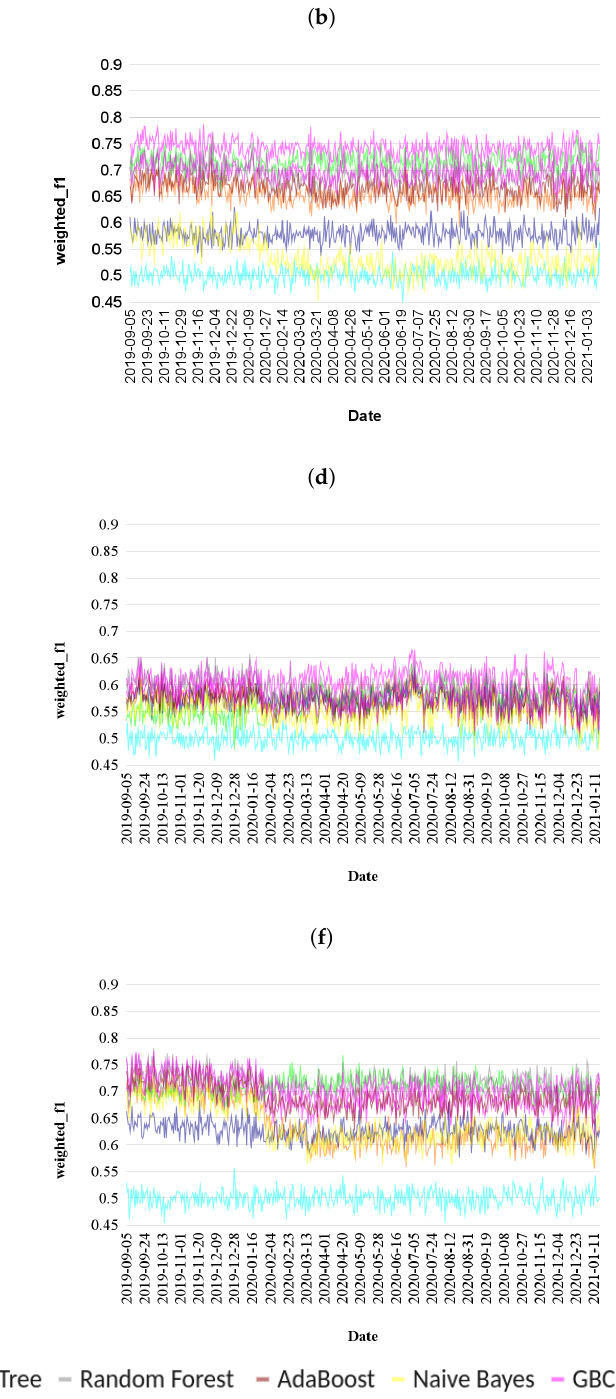
Figure A3. Performance evaluation (using weighted-f1) of the different models for each feature set in the 30-day training data. ( a ) Bag of Words; ( b ) Google Word2Vec; ( c ) Fake Word2Vec; ( d ) Lexical Categories (Empath); ( e ) Context-free features; ( f ) Best 15